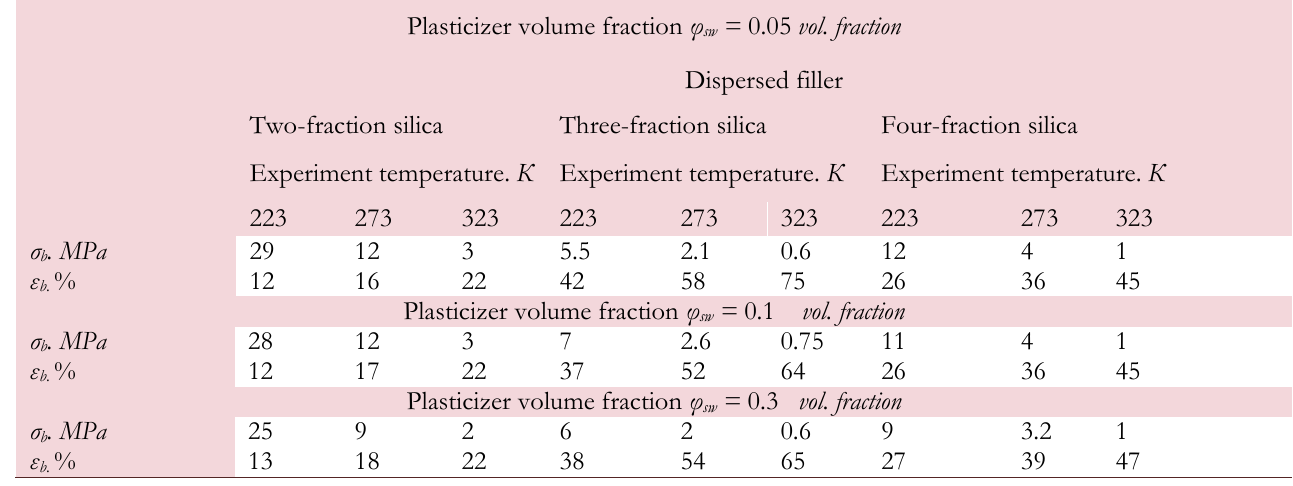
Table 3: Numerical experimentation results about dependence of rupturing stress from rupturing deformation of the PCM. According to the Tab. 3, PCM based on 3D-linked high-molecular rubbers, filled with four silica fraction mixture at